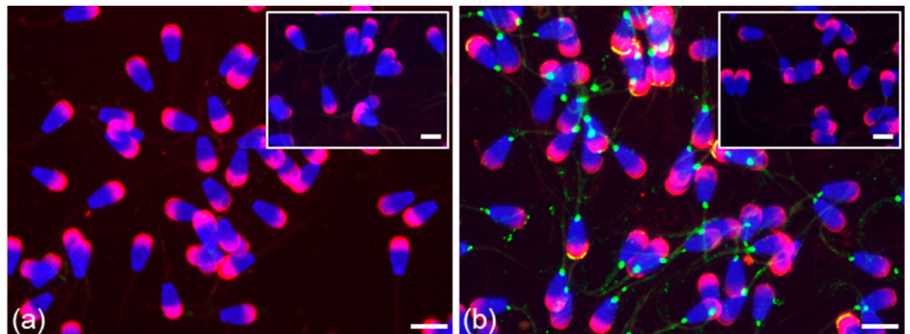
Figure 5. Localization of ESR1 and ESR2 in freshly ejaculated bull spermatozoa fixed in suspension with paraformaldehyde. Spermatozoa treated with anti-ESR1 antibody HC-20 (green) ( a ) without any positive reaction; spermatozoa treated with anti-ESR2 antibody H-150 (green) ( b ). Nuclear DNA was stained by DAPI (blue), and spermatozoa acrosomes were labeled by PNA lectin (red). Controls are displayed in the top right corner of the figures. Scale bar represents 10 µ m.